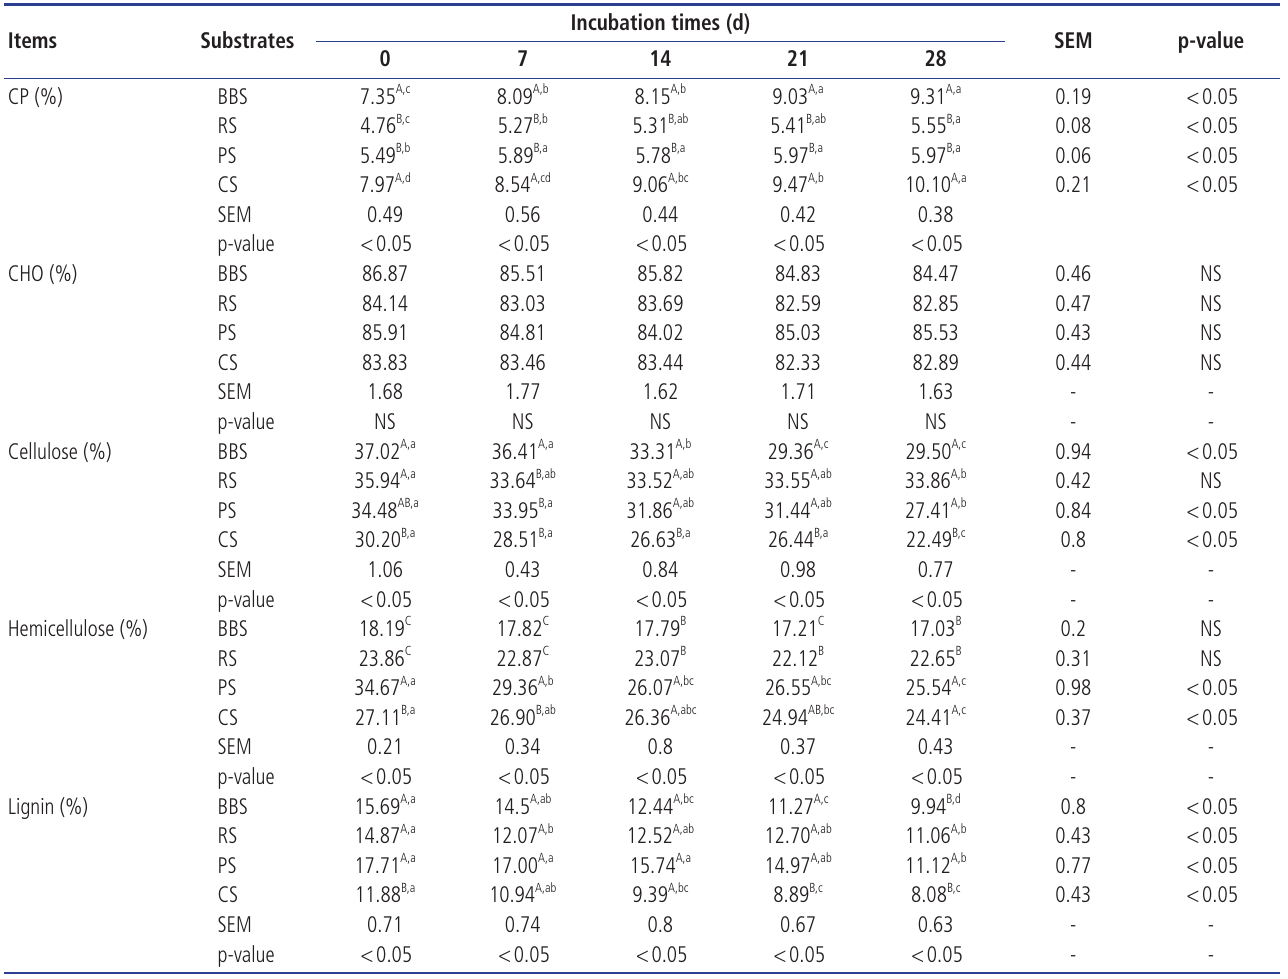
Table 2. The chemical composition (DM base) of broad bean stalks, rape straw, paddy straw and corn stalk cultured with Pleurotus ostreatus for different incubation times Items